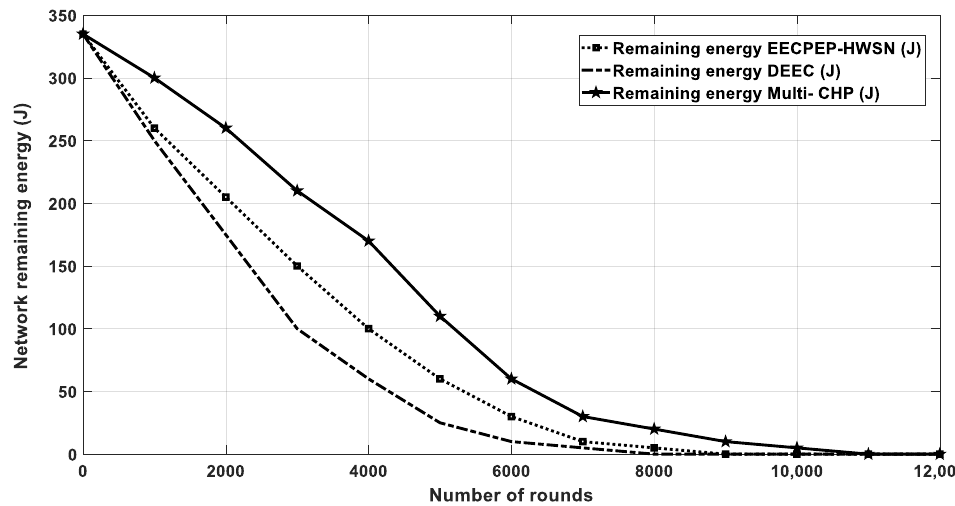
Figure 22. Residual energy after each iteration.